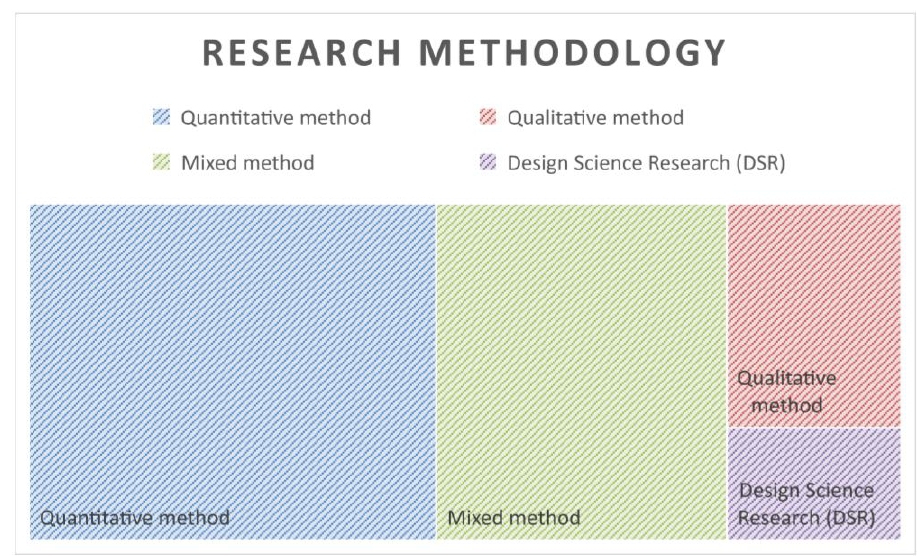
Figure 3. Research methodologies used in the studies.